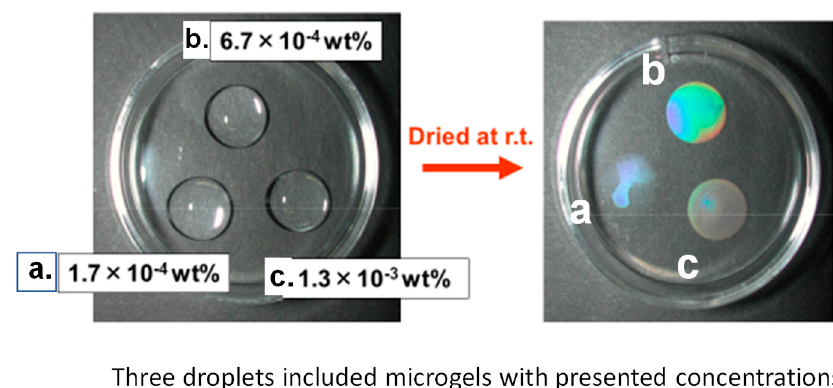
Figure 7. Structural colors observed in dried dispersions of PSt-core PNIPAM shell